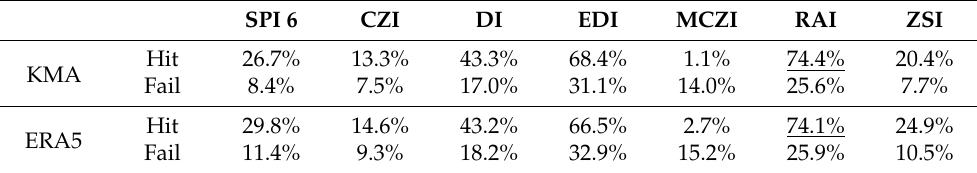
Table 3. Hit-scores at fifty-five KMA stations and corresponding ERA5 grid points for drought